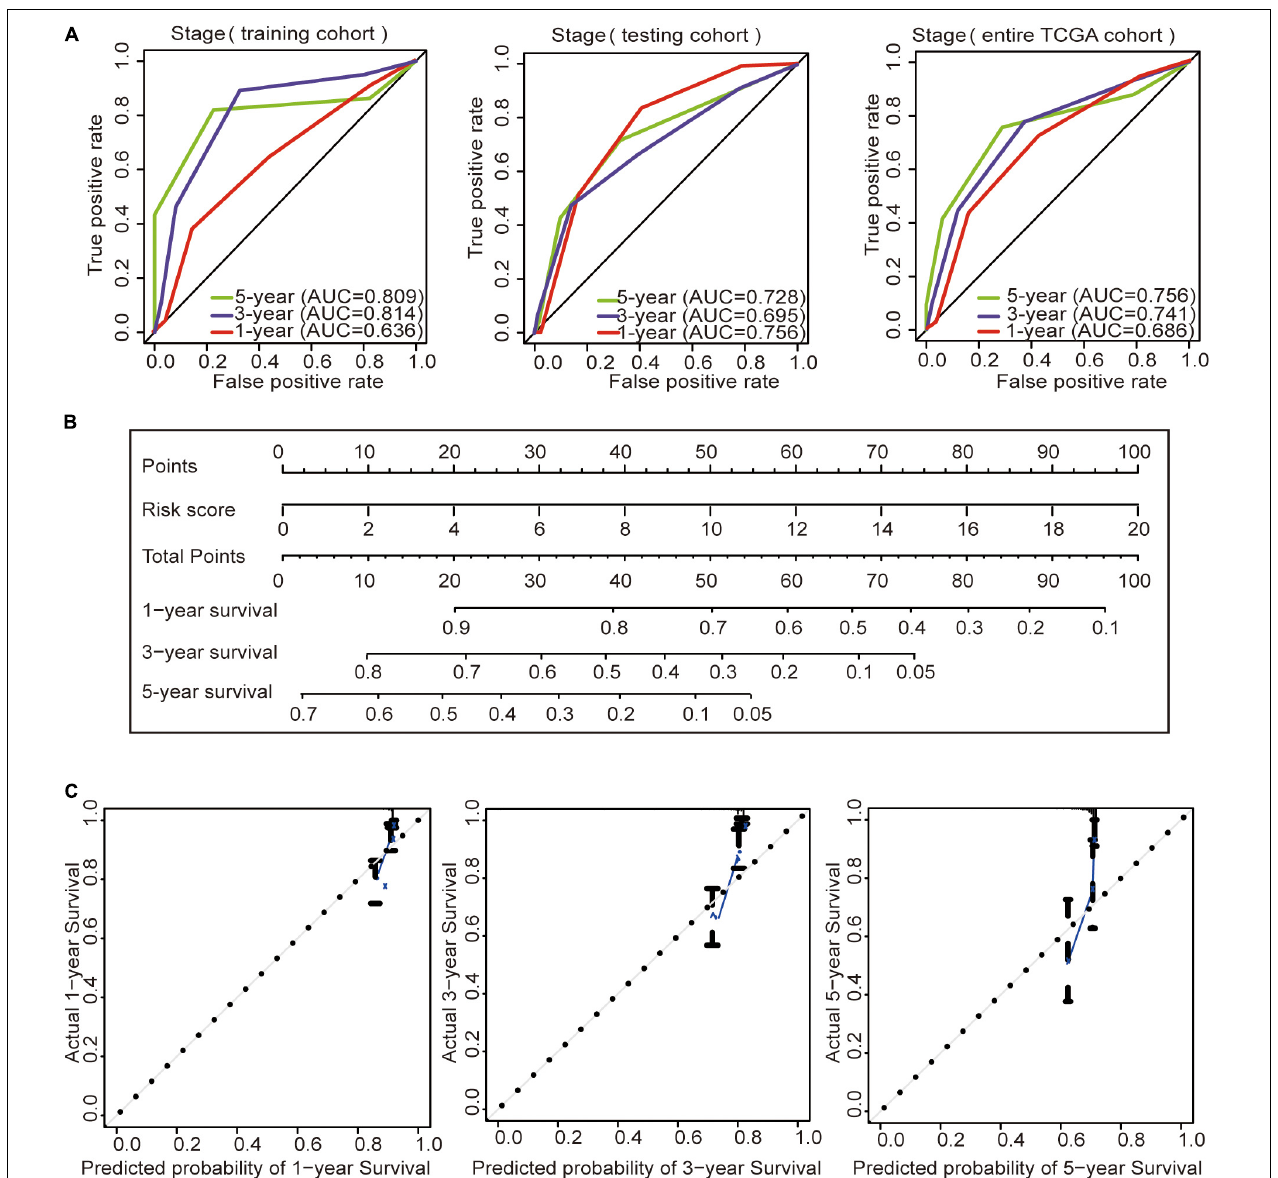
FIGURE 4 | Construction of the prognostic model and GSEA. (A) Time–ROC curves of the tumor stage prognostic model were compared in terms of the 1-, 3-, and 5-year OS in each cohort. (B) Construction of the nomogram was based on the risk score in the entire TCGA cohort. (C) Calibration plot for the internal validation of the nomogram.